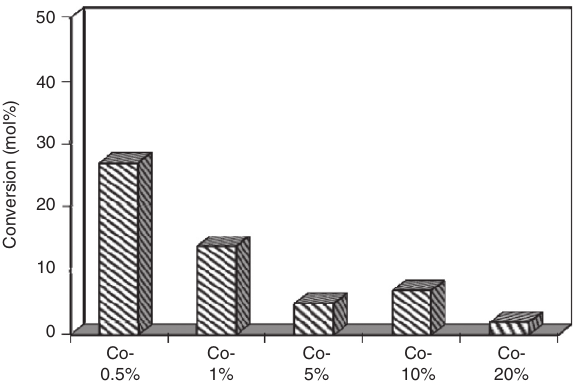
O . Black stripe and white bars 2 2